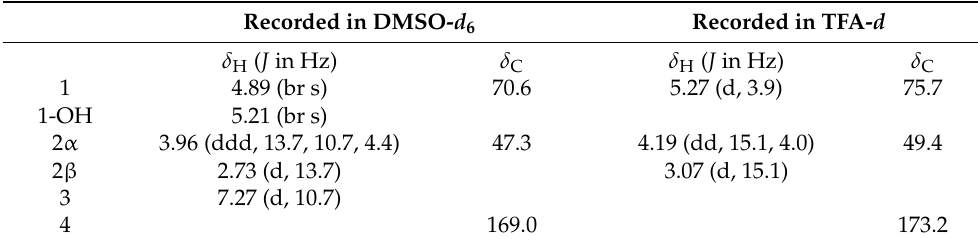
Table 1. 1 H and 13 C NMR data (500/125 MHz) for pandamine ( 1